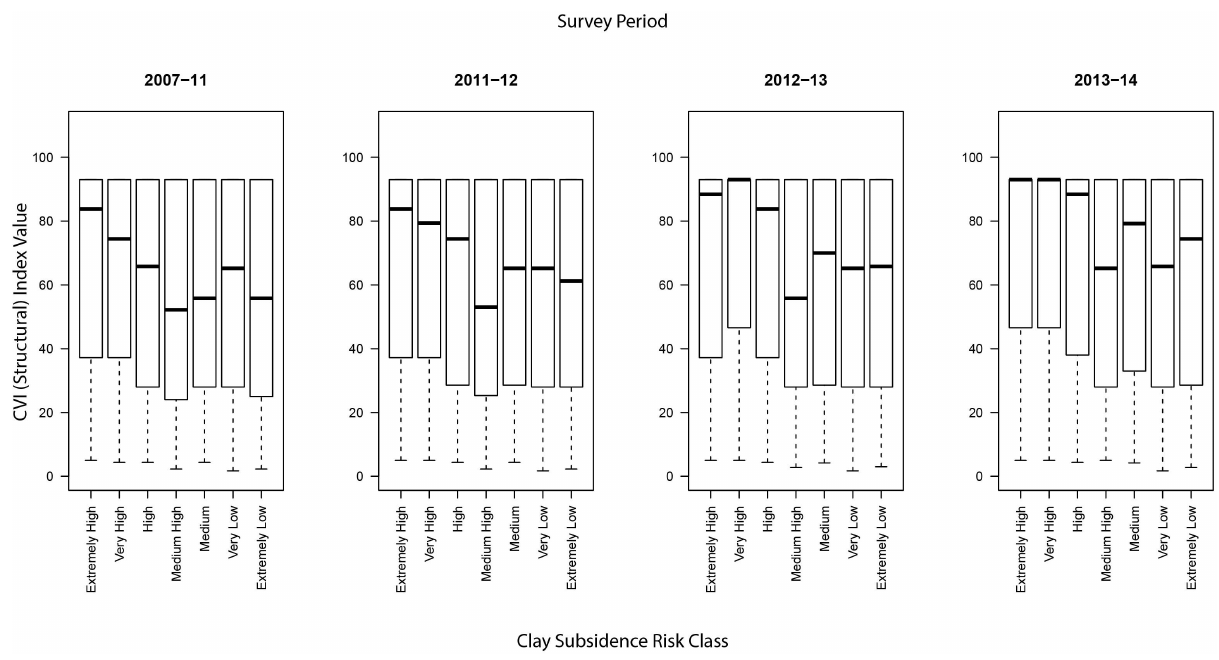
Figure 5. Clay subsidence risk against structural CVI (coarse visual